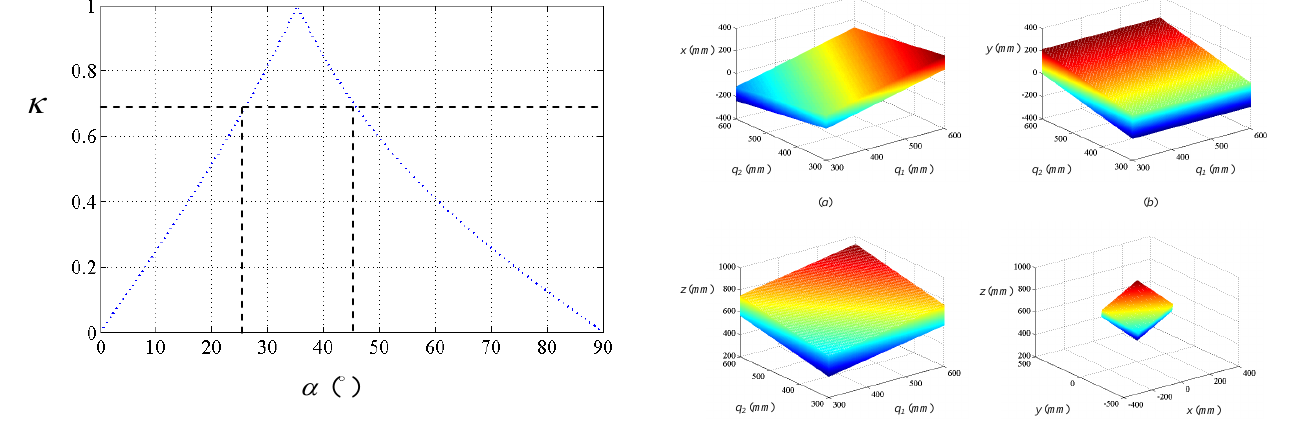
Figure 10. Relationship between the performance and the actuator layout angle.